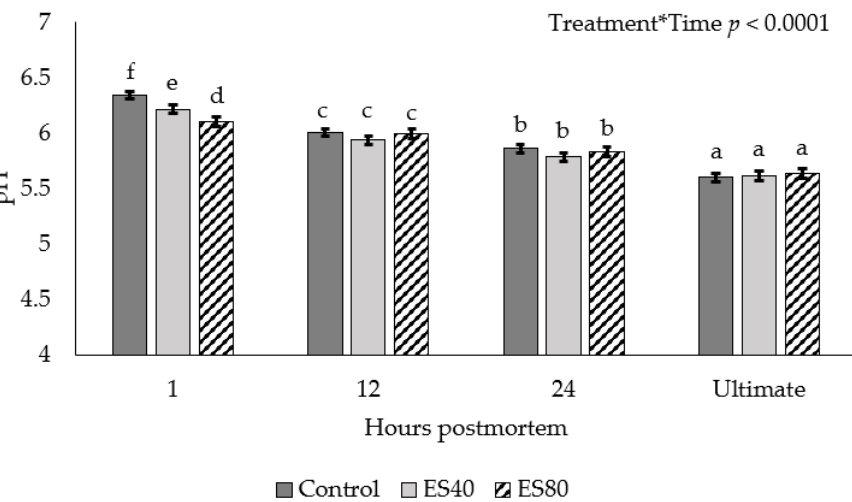
Figure 2. pH decline in beef carcasses subjected to low-voltage electrical stimulation prior to chilling. Data are depicted as least square means ± SEM. Treatments are as follows: Control = no ES, ES40 = 40 V of ES, ES80 = 80 V of ES. Electrical stimulation was applied for 60 s in 4 s on, 2 s off intervals. Measurements were taken at 1, 12, and 24 h postmortem in addition to ultimate pH. a–f Means with different subscripts differ ( p < 0.05).